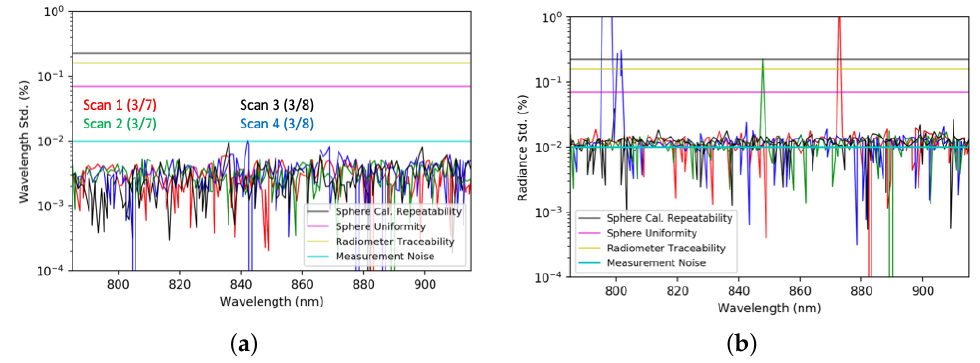
Figure 16. Processed GLAMR telemetry results from four scans collected over the 780–920 nm spectral range: ( a ) the variability of GLAMR wavelength and ( b ) the variability of GLAMR